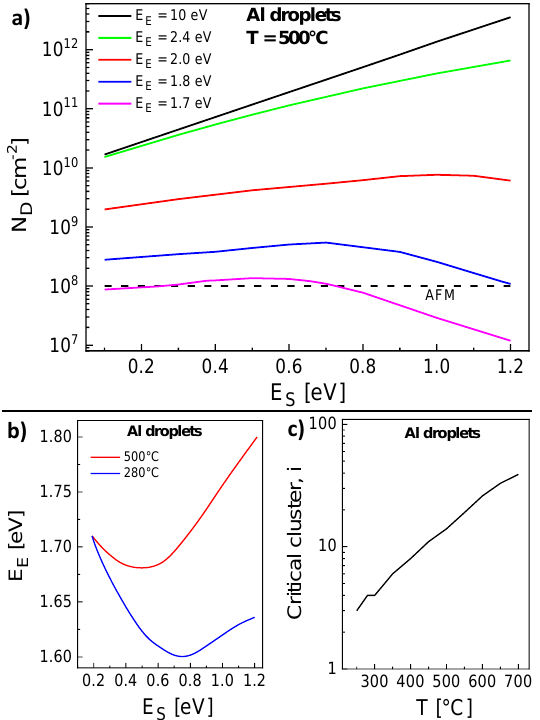
Figure 3. Parameterization of the rate model for Al droplets. ( a ) Calculated droplet densities N D for varied E S and E E at T = 500 °C. The dashed line indicates the experimental N D taken from AFM data. Agreement between experiment and model results is obtained for a range of pairs E S , E E . ( b ) Pairs E S , E E with agreement to the experimental N D for T = 500 °C and T = 280 °C. For E S = 0.19 eV, E E = 1.71 eV agreement is achieved for both temperatures. ( c ) Critical cluster size i at the end of the deposition time as function of T